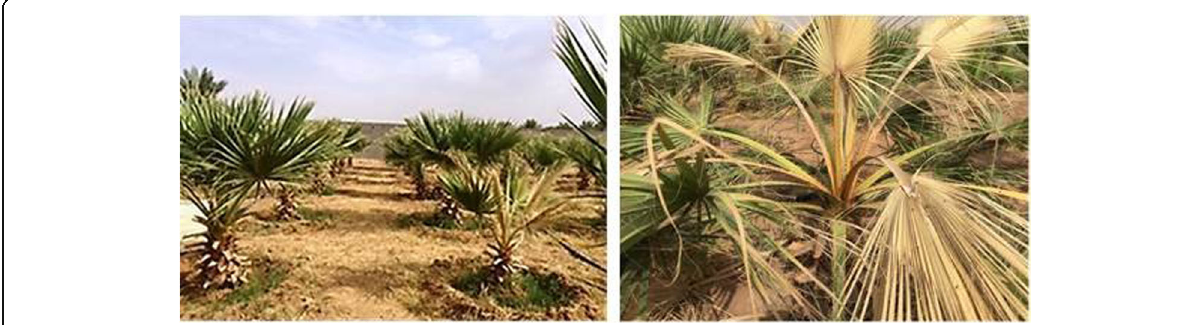
Fig. 1 Symptoms of terminal bud rot of Washingtonia robusta trees in the field: diseased palms are individually scattered in the field (left) and wilted young leaves in the center and older pale green to brown